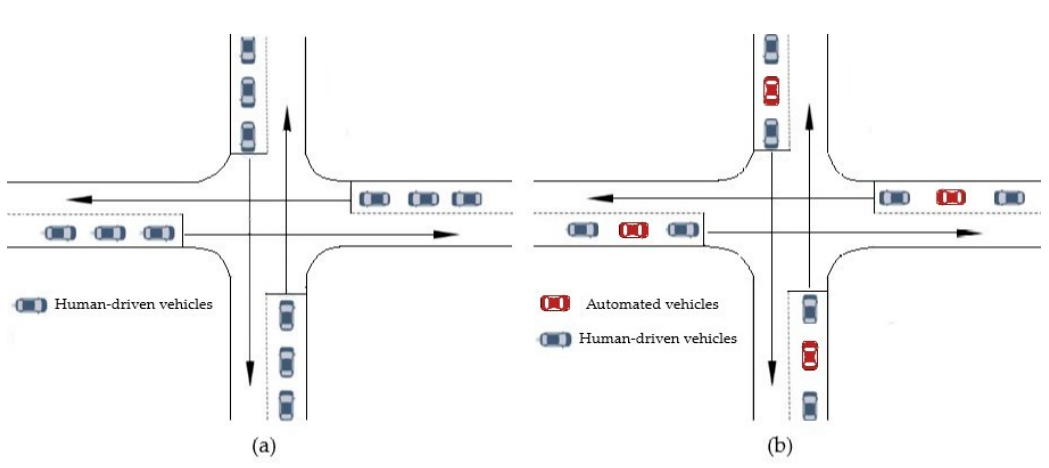
Figure 6. Comparison of experiments at a non-signalized intersection: ( a ) the all human-driven vehicle experiment with a 0% AV penetration rate; ( b ) the leading human-driven vehicle experiment with AV penetration rates ranging from 10% to 90% in 10% increments.